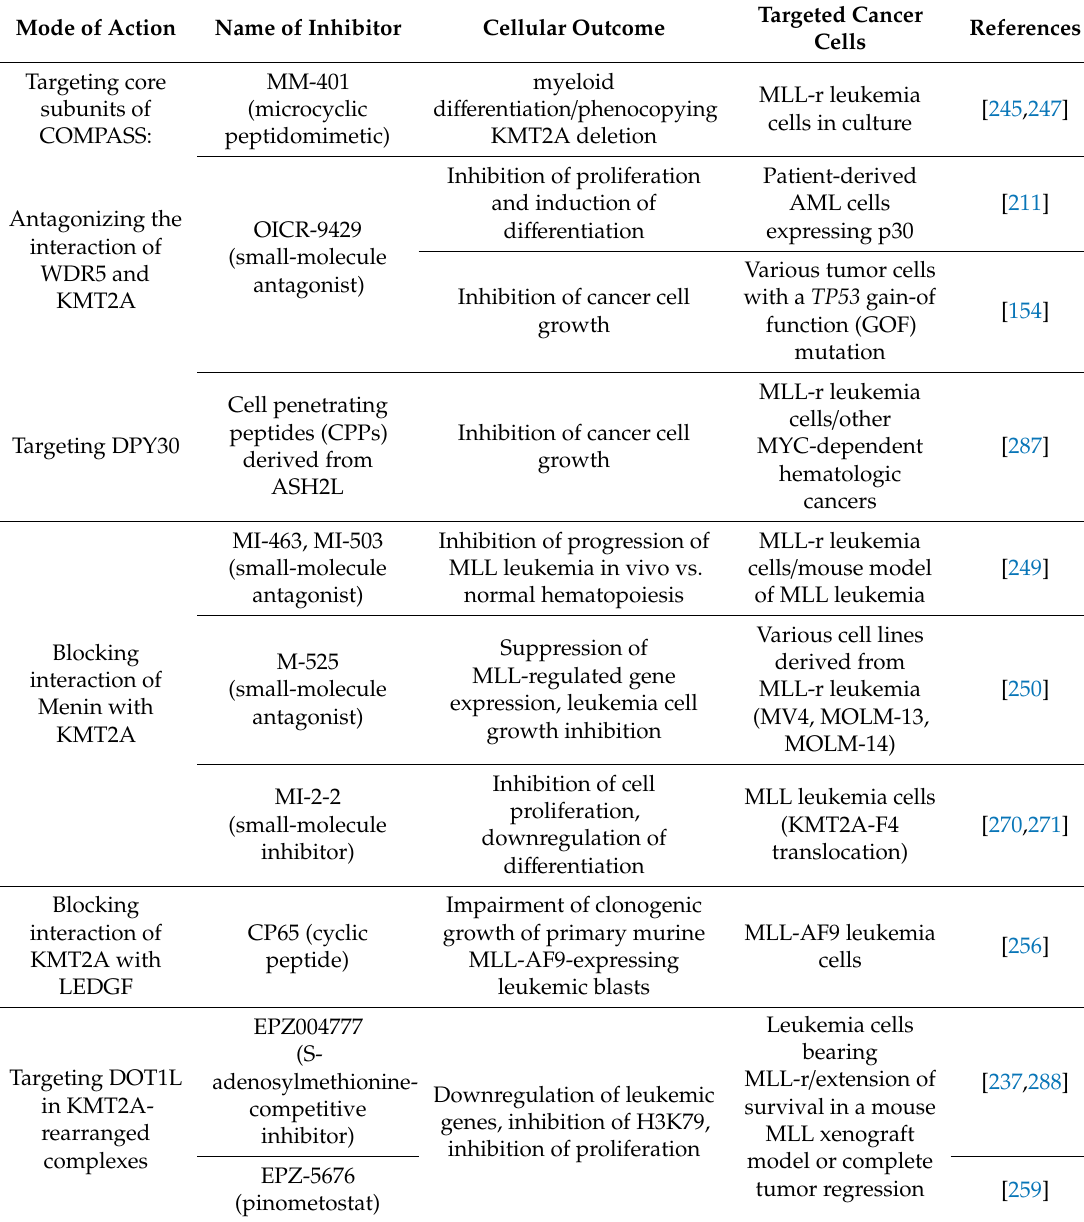
Table 2. Selected inhibitors targeting the aberrant activity of KMT2 complexes in cancer. Several major targets can be distinguished, including the core subunits (DPY30, RBBP5, ASH2L, and WDR5); LEDGF and Menin present in both wild-type (wt) MLL and MLL-fusion protein (FP) complexes; and “additional” proteins such as DOT1L, BRD4, CBP / p300, and fusion proteins (ENL) present in MLL-FP complexes. Other approaches to inhibit the actions of the mutated KMT2s, such as KMT2C and KMT2D, in cancer involve the use of repression complex blockers or contained glycolysis. More details areprovidedinthemaintext. TNBC:triple-negativebreastcancer;